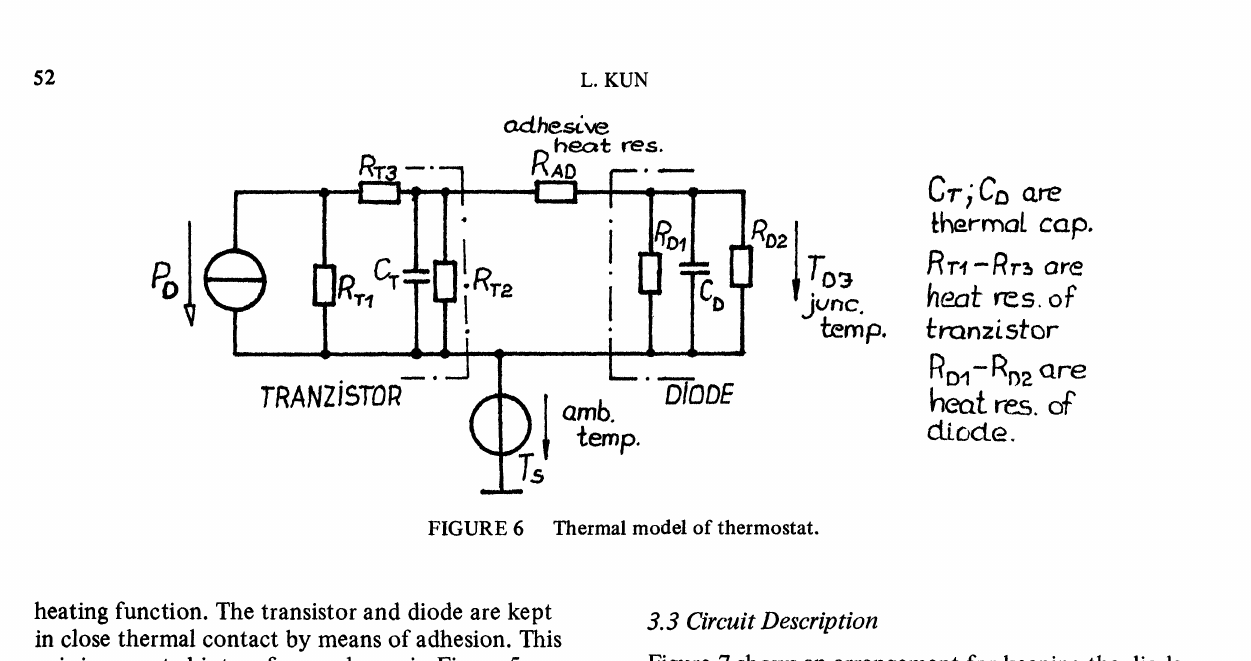
FIGURE 6 Thermal model of thermostat.